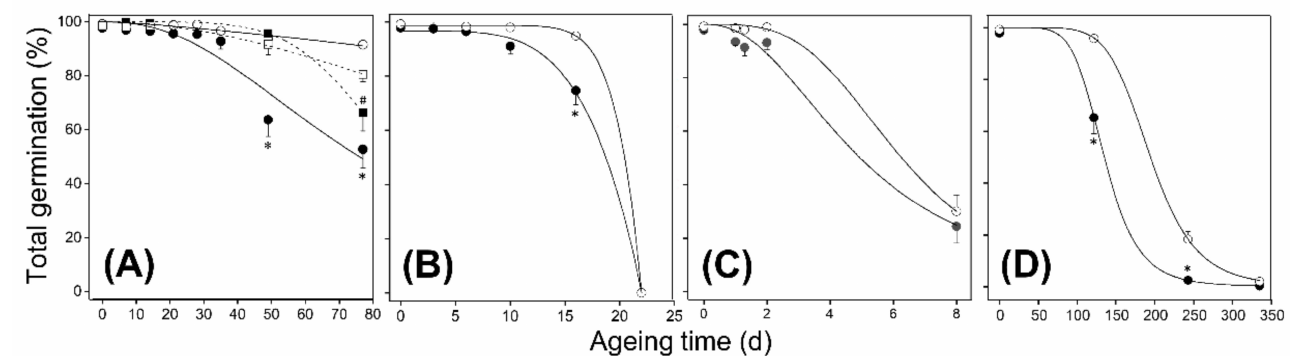
Figure 3. Survival curves of wild type seeds (WT, ecotype Columbia-0 [Col-0], closed symbols) and Atfahd1a-1 (fumary- lacetoacetate hydrolase domain-containing protein 1a) T-DNA insertional mutant seeds in the Col-0 background exposed to different regimes of controlled deterioration (CD) and accelerated ageing (AA) at 40 ◦ C, as well as to ageing under ambient temperatures. At indicated intervals, seed viability was assessed by scoring total germination after 14 d at 20 ◦ C. Circles and squares indicate seeds of the first (F 1 ) and second (F 2 ) plant generation, respectively. Open and closed symbols refer to WT and Atfahd1a-1 seeds, respectively. ( A ) Seeds exposed to CD at 59.4 ± 1.1% RH. ( B ) Seeds exposed to CD at 74 ± 0.5% RH. ( C ) Seeds exposed to AA at 100% RH. ( D ) Seeds aged under ambient temperature and 68.2 ± 2.0% RH. Data refer to means ± SE ( n = 6 replicates of 100 seeds for each line). Curves were drawn after fitting to the logistic function. Asterisks (for F 1 ) and hashes (for F 2 ) indicate significant differences between WT and Atfahd1a-1 at the same ageing intervals (Mann-Whitney U tests, p < 0.05). Error bars within symbols are not